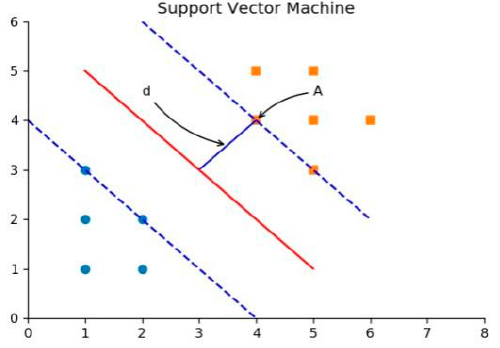
Figure 8. Support vector machine in two-dimensional space.